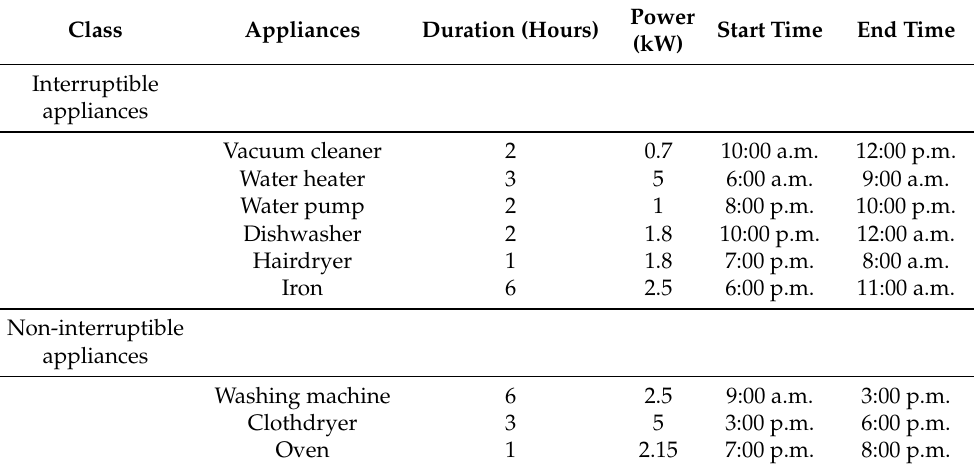
Table 2. Smart appliances specifications and